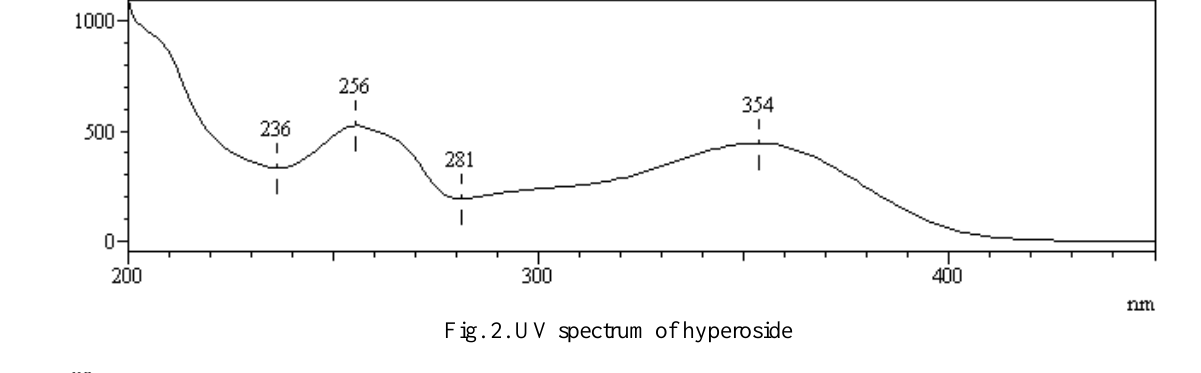
Fig. 2. UV spectrum of hyperoside